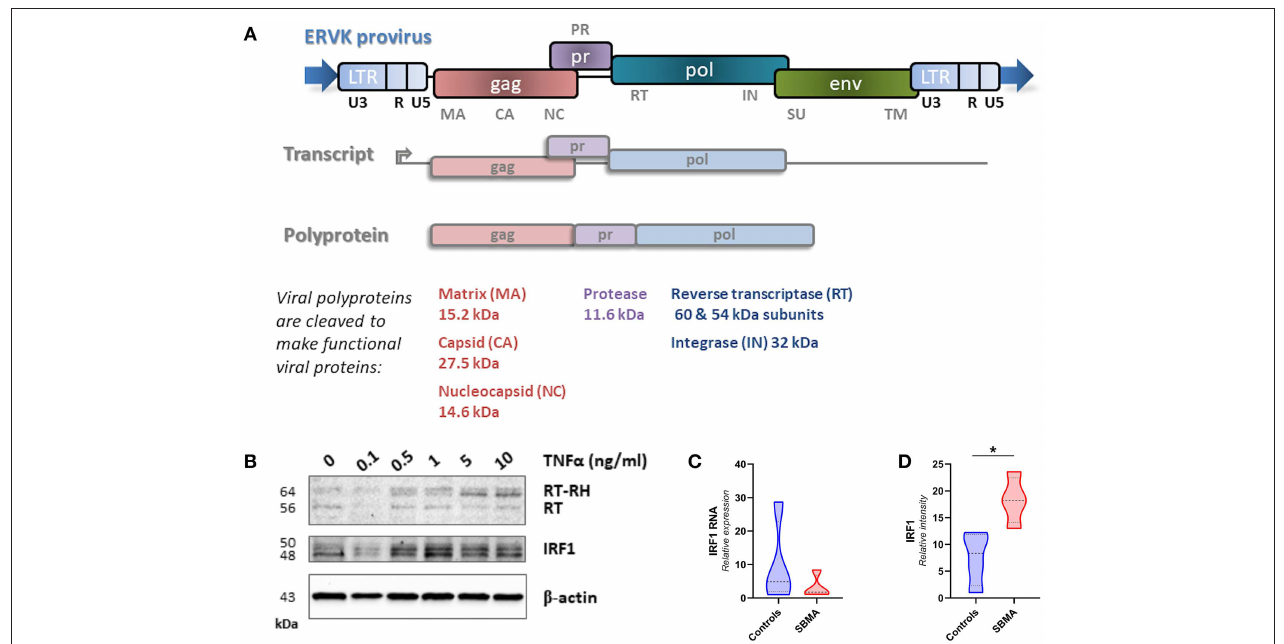
FIGURE 1 | Genomic insertions of ERVK with intact open reading frames can produce a variety of mature viral proteins and are induced by pro-inflammatory signals. (A) The ERVK provirus is comprised of the typical retrovirus genes gag , pro , pol , and env . Multiple ERVK RNA transcripts are produced from a provirus. This diagram depicts the gag - pro - pol transcript. This transcript is translated to produce the Gag-Pro-Pol polyprotein, which is cleaved by the mature protease enzyme to produce individual viral proteins. Gag structural proteins (capsid, matrix and nucleocapsid) and pol -derived reverse transcriptase (RT/RT-RH heterodimer) integrase (IN) proteins were examined in this study. The cellular role of most ERVK proteins remains unknown; however, the ERVK Env protein is known to be neurotoxic ( 20). (B) ERVK reverse transcriptase (RT) levels dose-dependently increase with pro-inflammatory stimulus in immune cells. Peripheral blood mononuclear cells (PBMC) were treated with increasing doses of pro-inflammatory cytokine TNF α and evaluated for ERVK RT and IRF1 expression. As described elsewhere ( 19), the pro-inflammatory transcription factor IRF1 participates in driving increased levels of ERVK transcription and RT protein expression. (C,D) Similar IRF1 transcript expression in control and SBMA cases (C) , despite evidence of elevated IRF1 protein expression in SBMA as compared with controls ( D , * p < 0.05).